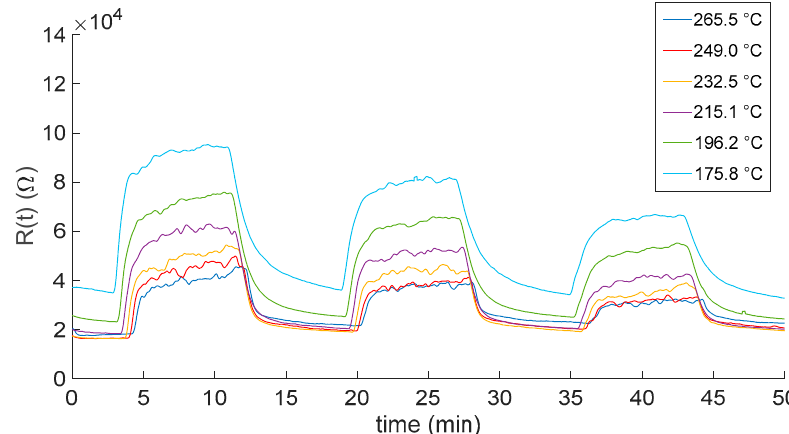
Figure 6. Measured In 2 O 3 − x sensor response as a function of time when gas pulses (8 min long) consisting of mixtures of air and NO 2 (10, 5 and 2.5 ppm) are injected into the measurement chamber. Gas pulses are followed by recovery phases (8 min long) in pure dry synthetic air. Different colors represent responses obtained at the different working temperatures (see legend).